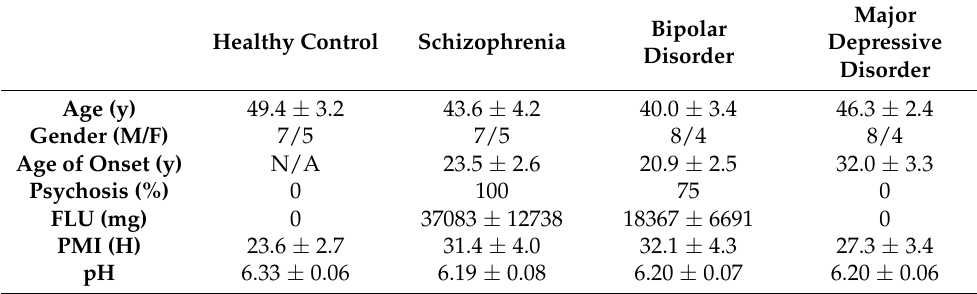
Table 1. Demographics and clinical information of donors of anterior cingulate cortex